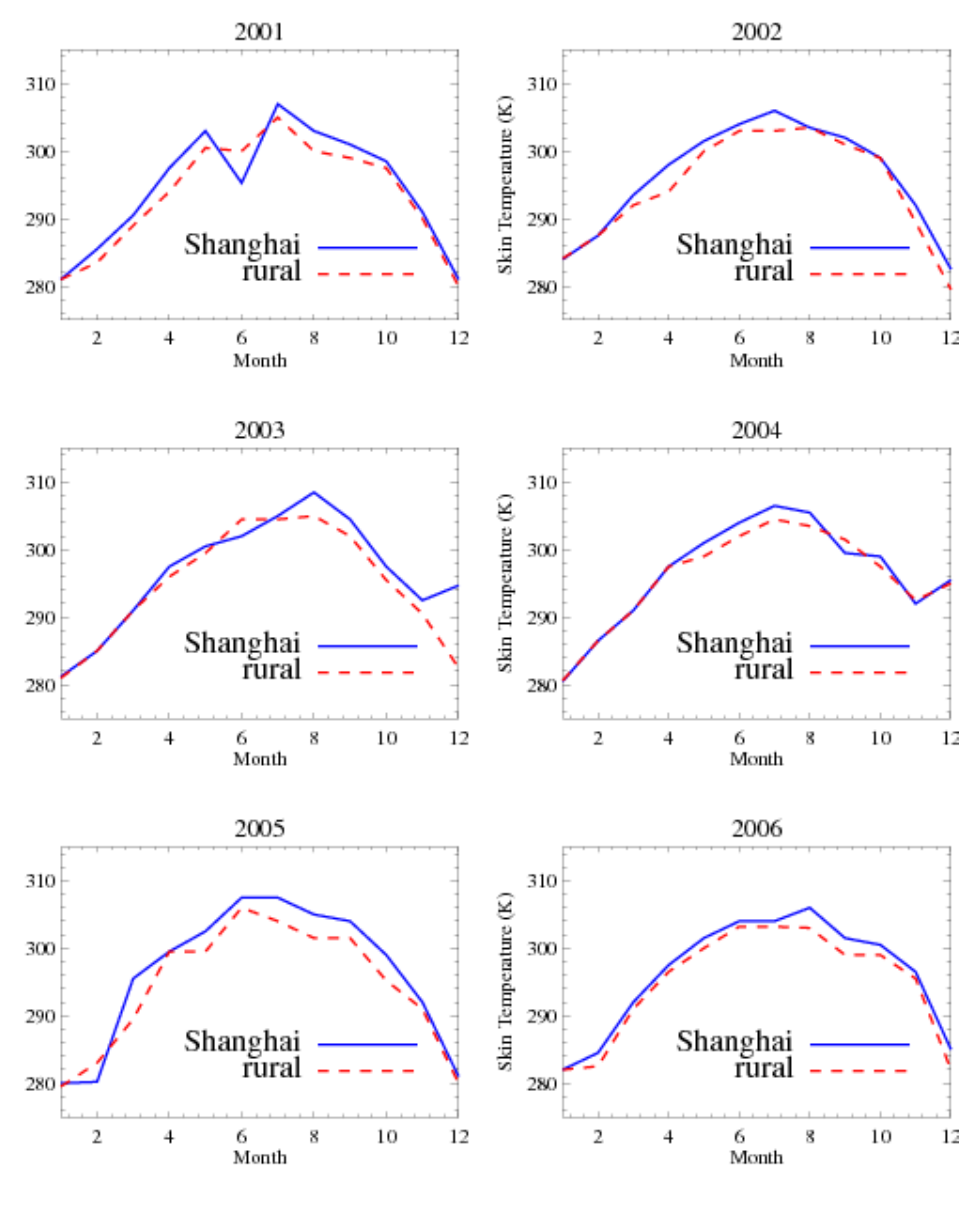
Figure 5. Monthly averaged T for Shanghai and rural areas in (a) 2001, (b) 2002, skin (c) 2003, (d) 2004, (e) 2005, and (f) 2006, where red solid line represents Shanghai and blue solid line represents